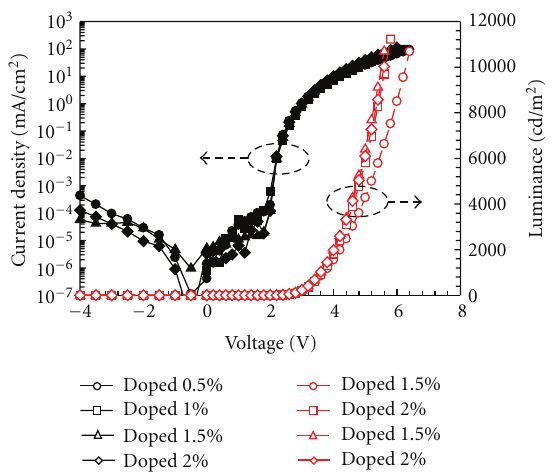
Figure 11: J - V - L plot of red PHOLEDs doped with di ff erent concentrations (0.5–2%) of Ir(phq) 2 acac in Bebq 2 .